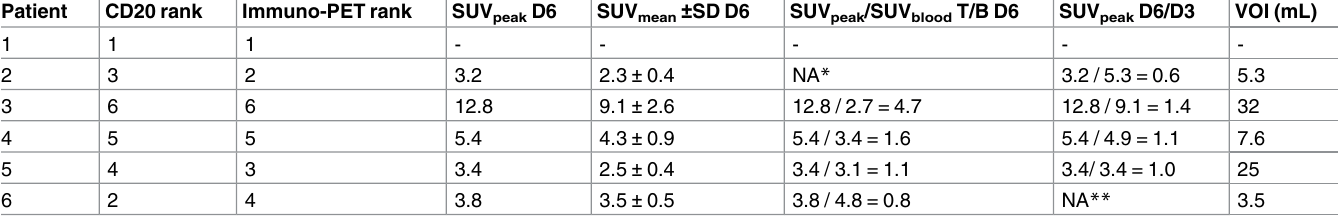
Table 3. Quantitative tumor uptake measuresof 89 Zr-rituximab in the biopsied tumor lesions. Patient CD20